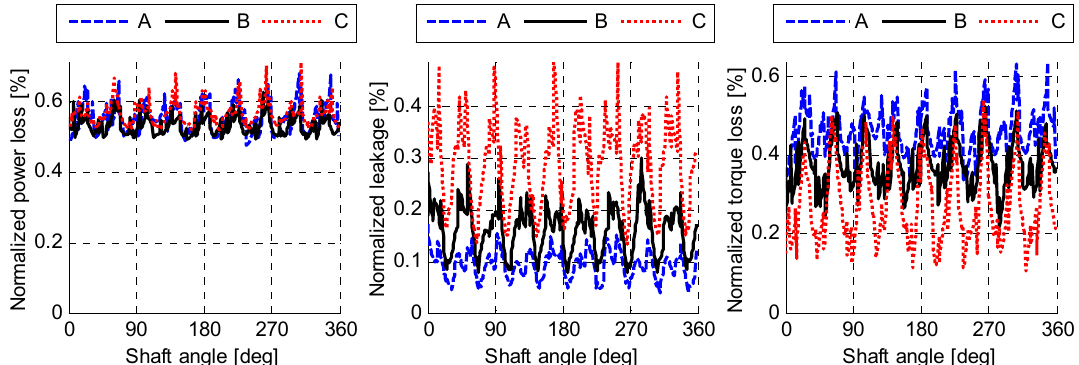
Figure 14. Normalized cylinder block/valve plate interface performance comparison for different sizes.